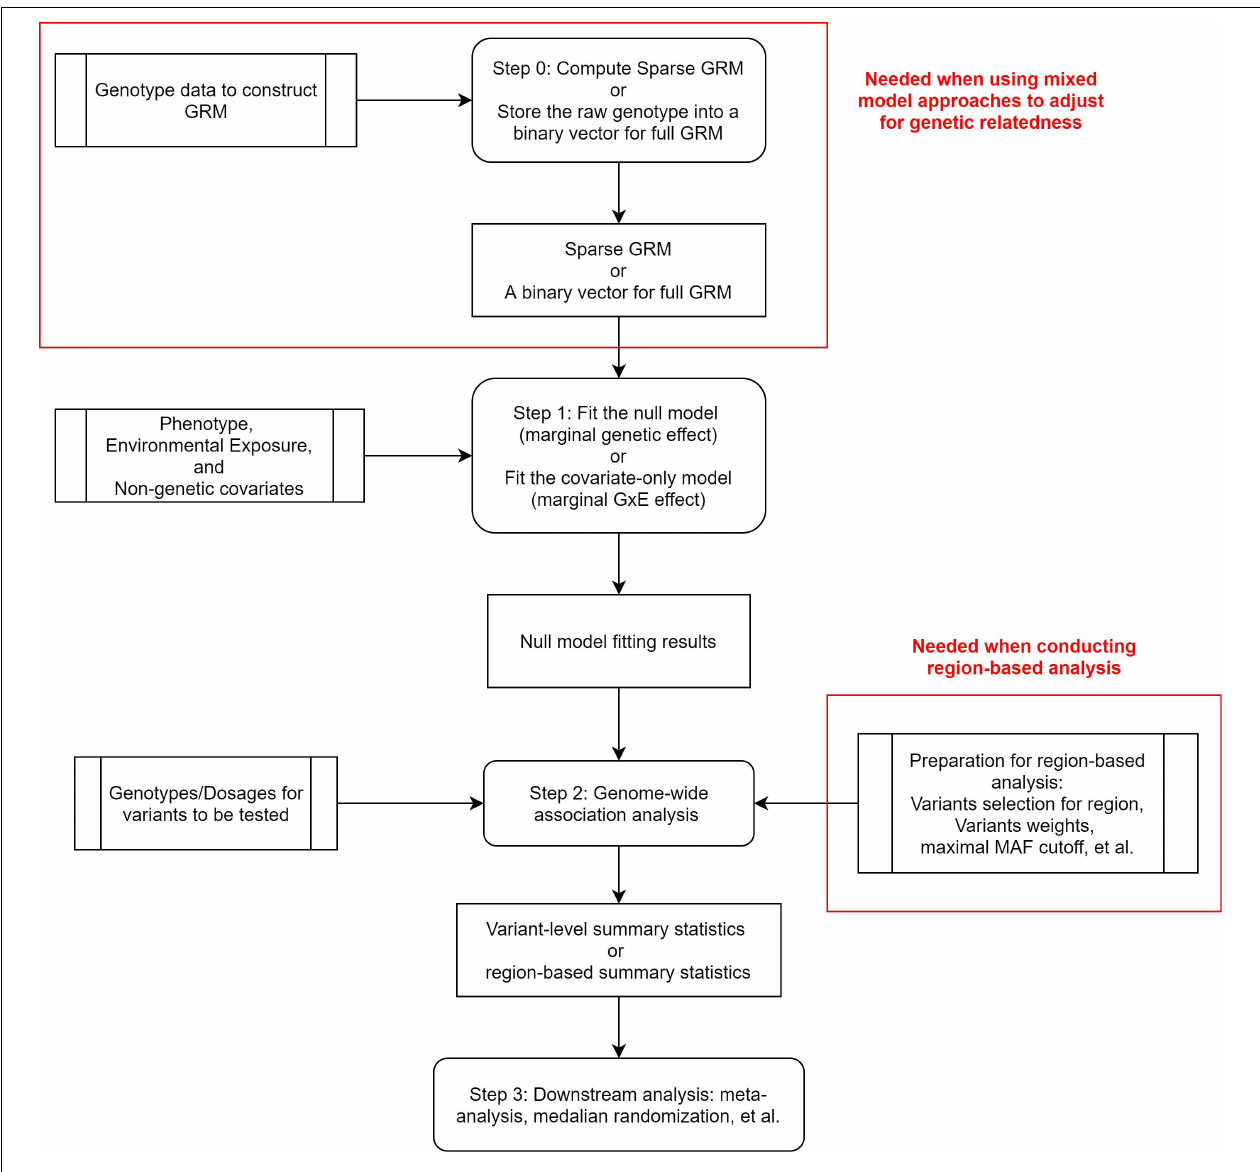
FIGURE 2 | Flowchart of score test association